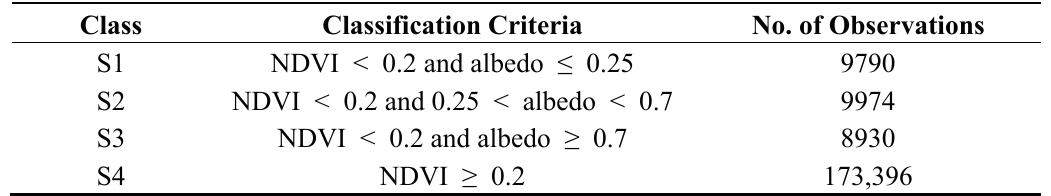
Table 3. Four classifications based on combinations of Normalized Difference Vegetation Index (NDVI) and albedo (remotely sensed product introduced in Section 2.1.2), with their corresponding numbers of